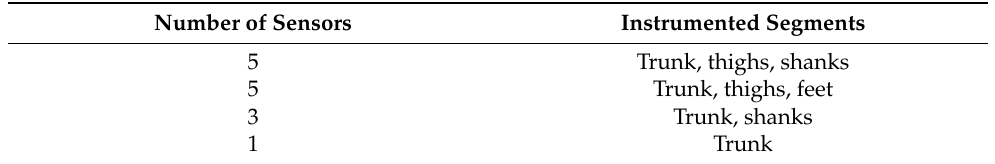
Table 1. List of the sensor networks investigated for the estimation of 3D BCoM acceleration and velocity using the wearable